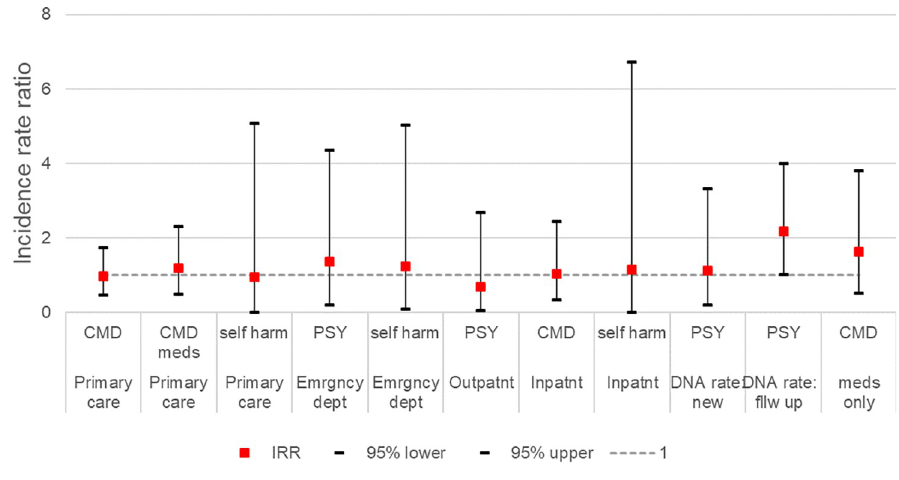
Fig 5. Annual incidence rate ratios for Gypsy and Traveller cohort compared with general population, adjusted for sex/age/WIMD 2014 quintile.